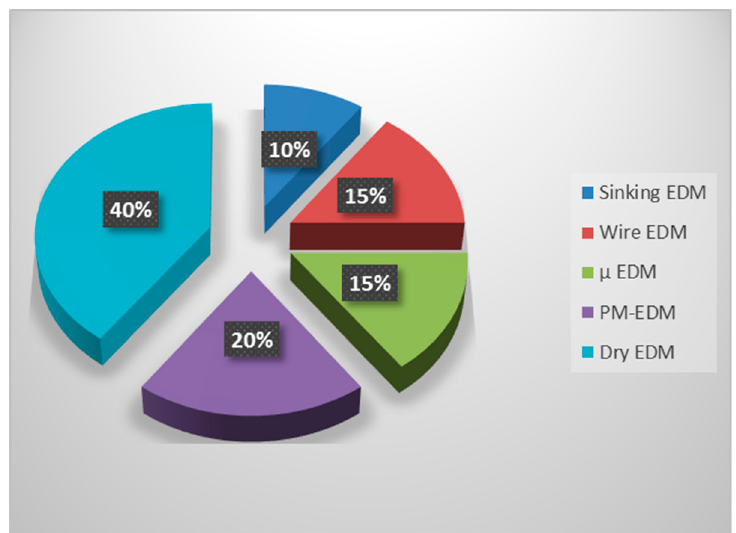
Figure 16. Percentage of research related to EDM processes.